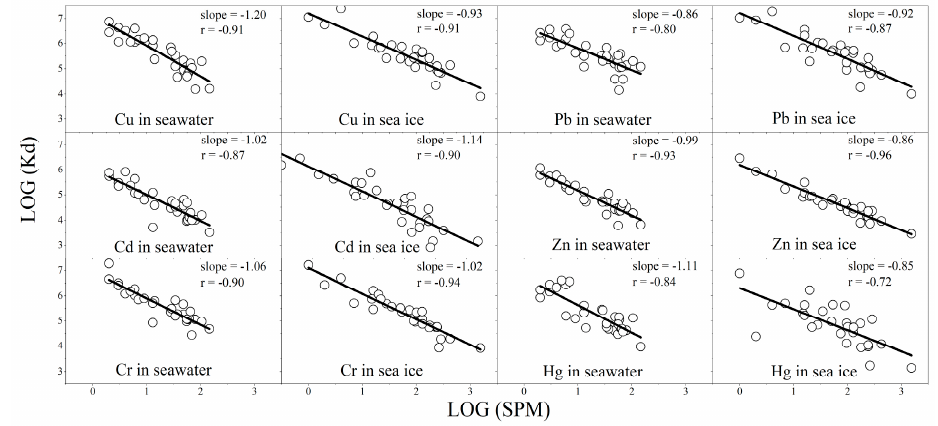
Figure 4. Partition coefficients for trace metals for all 30 coastal sites as a function of SPM.